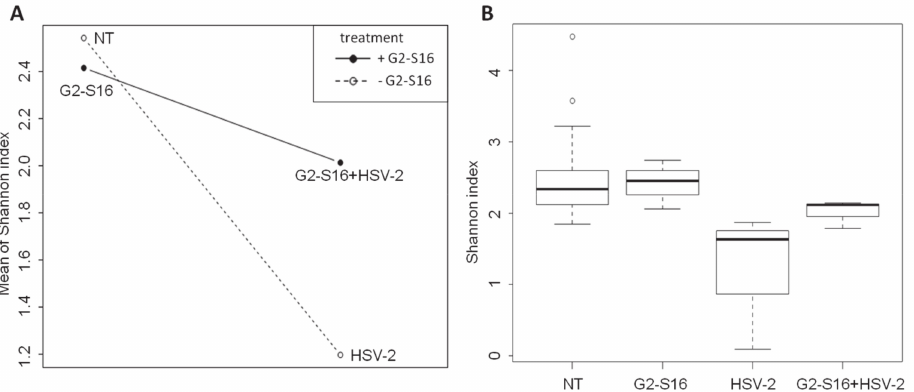
Figure 6. Comparison of vaginal microbiome diversity within groups of studied mice. Diversity is expressed based on the Shannon Index. ( A ) Interaction plot showing the Shannon index mean relation between groups using as independent factor HSV-2- infected group (group HSV-2) and treated mice with G2-S16 dendrimer and with HSV-2 (group G2-S16 + HSV-2). ( B ) Boxplot representing Shannon index means for di ff erent groups and the maximum and minimum values showing data distribution within